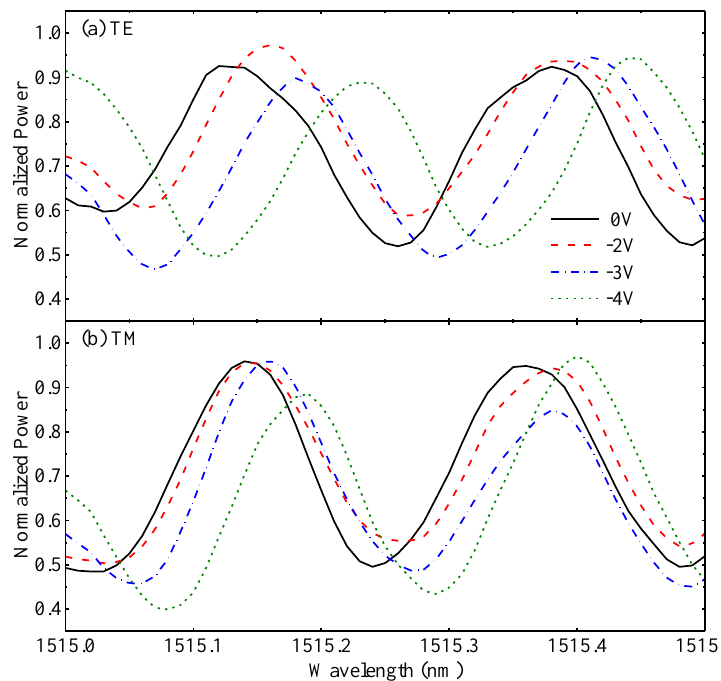
Crystals 2021 , 11 , x FOR PEER REVIEW 2 of 11 Figure 6. PhaseshiftsoftheFabry–Perotresonancesatreversebiasvoltagesfor( a )TEand( b )TMpolarization. Figure 6. Phase shifts of the Fabry – Perot resonances at reverse bias voltages for ( a ) TE and ( b ) TM polarization.